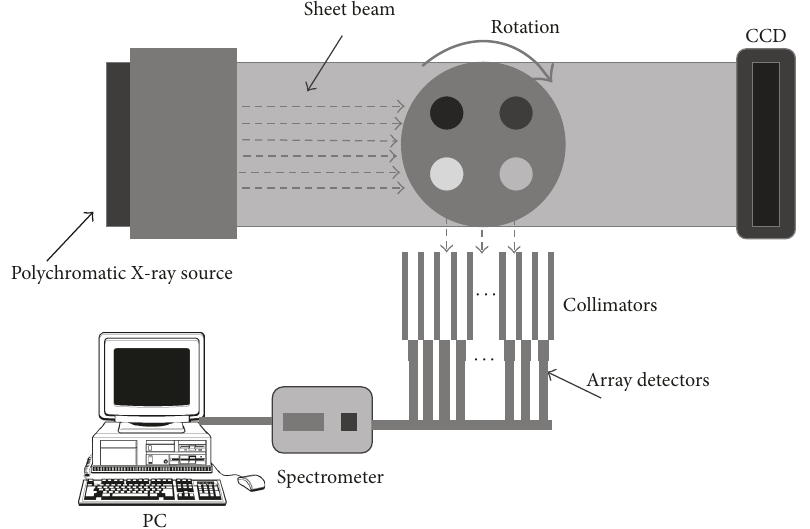
Figure 1: Schematic diagram of XFCT imaging system using sheet-beam and linear detector arrays.